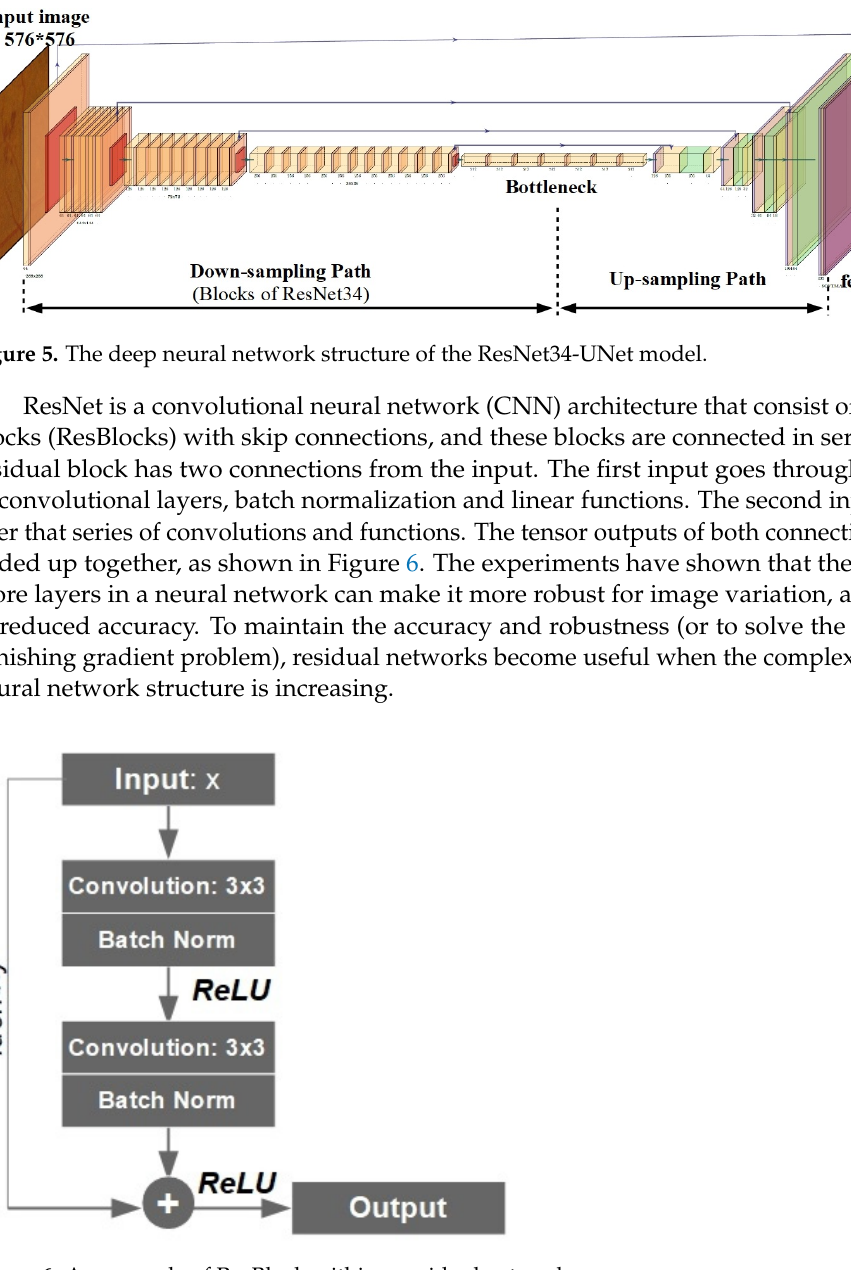
Figure 4. Deep neural network structure of the U-Net model.